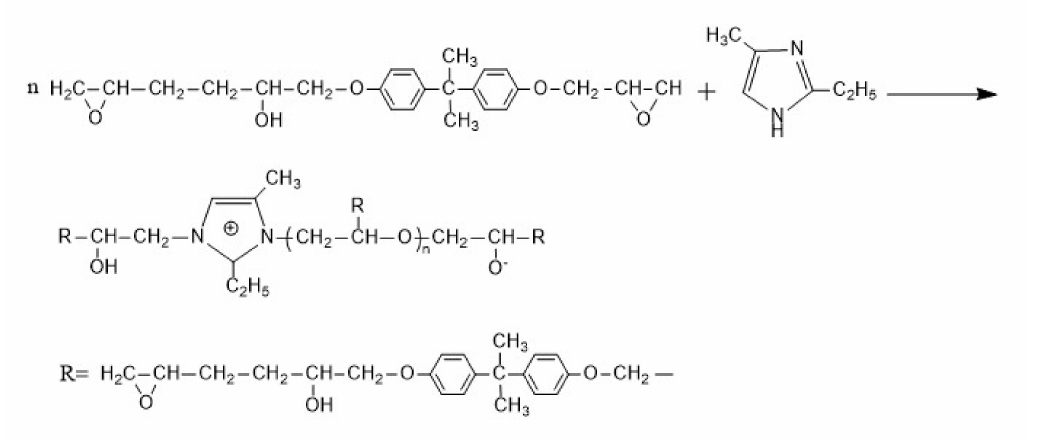
Figure 9. Curing process of E-44 epoxy resin and 2-ethyl-4-methylimidazole. After 14 days of self-healing, the compressive strength recovery rates of CCM0, CCM1 and CCM2 were 54.3%, 83.9% and 90.1%, respectively. Compared with CCM0, the compres- sive strength recovery rates of CCM1 and CCM2 increased by 54.5% and 65.9%, respectively. The results indicate that WM2 has better self-healing ability for pre-damaged mortar. This is mainly due to the higher initial core content and better compactness of WM2 than WM1 (the microcapsules used in the self-healing experiments were prepared 60 days in advance), which ensured that the self-healing mortar had more healing agent, resulting in a higher compressive strength recovery rate for CCM2 than CCM1. In addition, the micromechanical properties of WM2 were better than WM1, which reduced the risk of rupture during